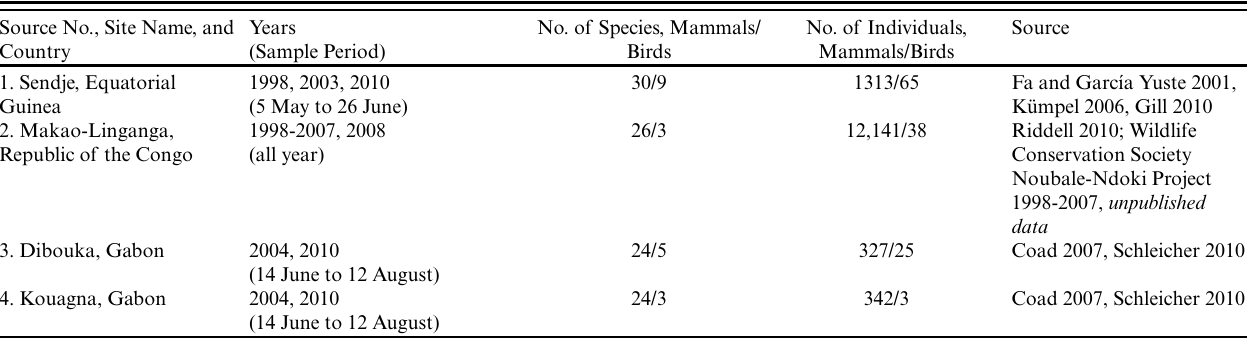
Table 1 . Details about sites, years sampled, and sample period for four time series used to calculate the offtake pressure indicator. Sample sites are shown in Figure 1.